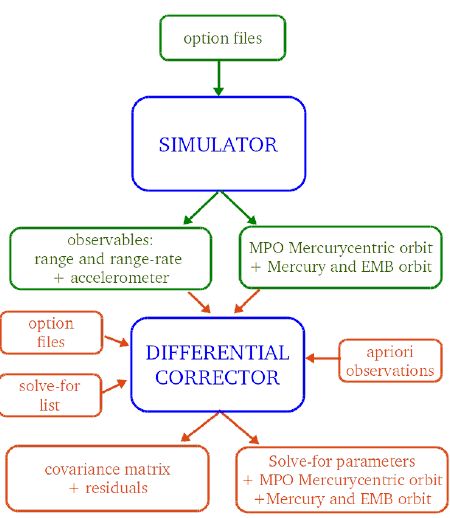
Figure 1. Block diagram of the ORBIT14 code: simulation and differential corrections stages. Green arrows refer to simulator inputs/outputs and orange arrows to corrector inputs/outputs. The input option files for simulator and corrector are similar and include, for example, the state vector of the spacecraft at the initial epoch, the number of considered arcs, the time steps for the orbit propagation of the spacecraft, Mercury and EMB, the time sampling for range, range-rate and accelerometer data.